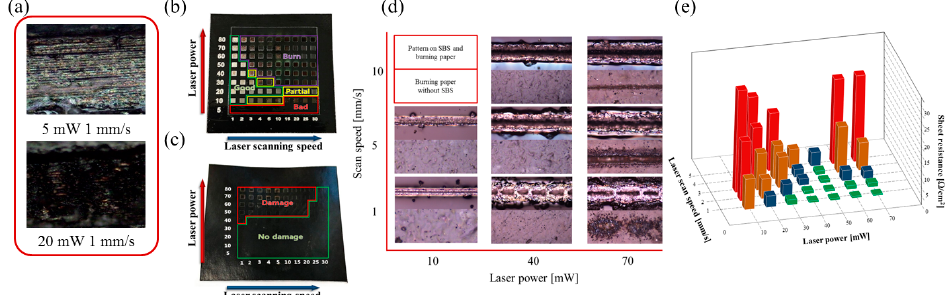
Figure 4. Optical microscopy (OM) image of burning paper after irradiating a laser with laser powers of 5 mW and 20 mW, scan speed of 1 mm s − 1 ( a ); Patterns fabricated on the burning paper by varying the laser power from 5 mW to 80 mW and the scan speed from 1 mm s − 1 to 30 mm s − 1 ( b ) and burning paper with the composite SBS removed after pattern fabrication according to the laser power and scan speed on composite SBS ( c ); Optical image of top view of fabricated patterns (top image) and burning paper by laser reduction of the Ag precursor with various laser parameters (bottom image) after removal of the SBS composite ( d ); Sheet resistance graph of patterns fabricated by laser reduction with various laser parameters ( e ).